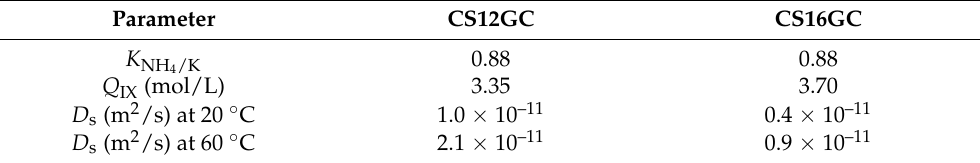
Table 3. Values of the parameters in Equations (1)–(7) estimated from experimental breakthrough curves.